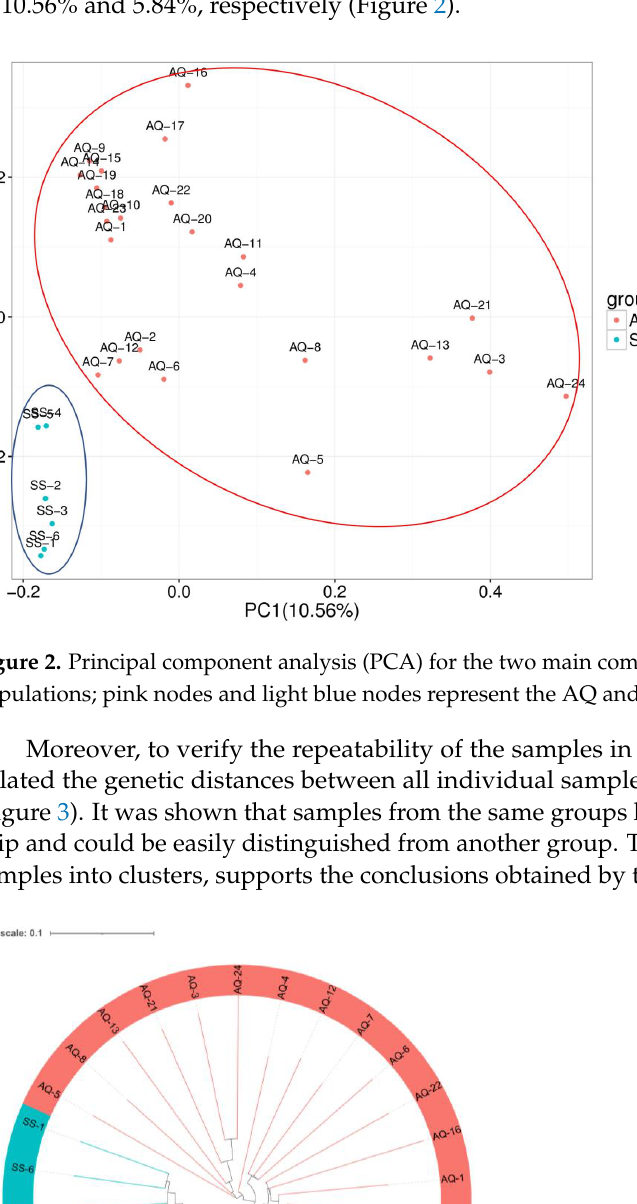
Figure 3. Evolutionary tree constructed from copy number variation regions (CNVRs); pink stripes and light blue stripes represent the AQ and SS groups,